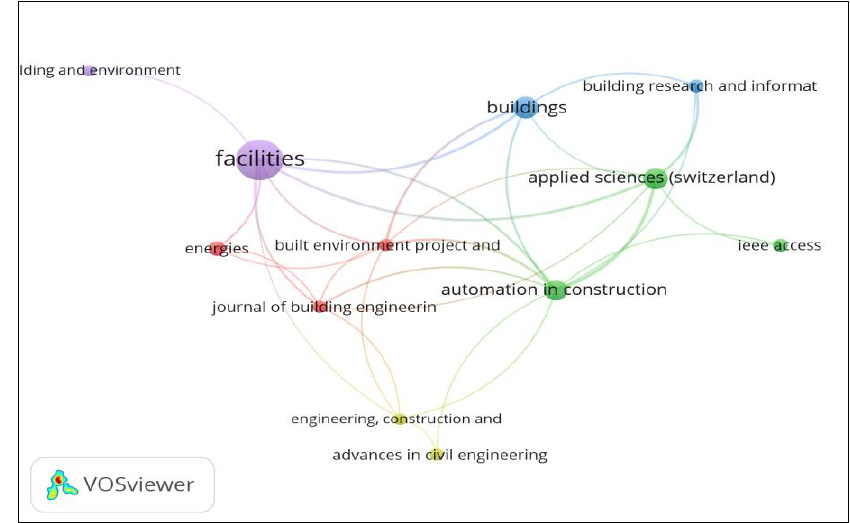
Figure 3: Citation per